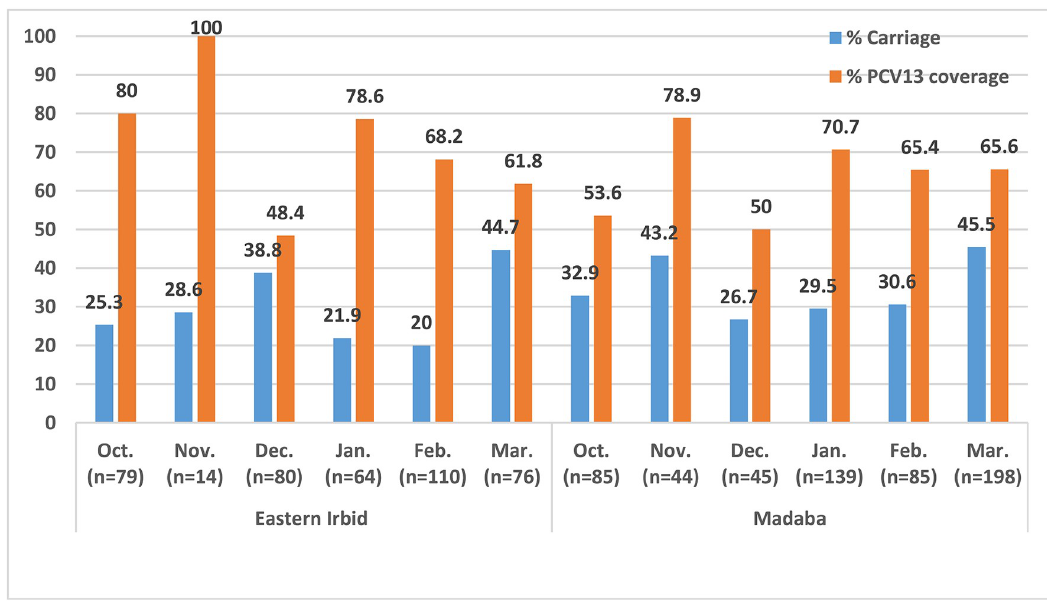
Fig 1. Distribution of carriage and PCV13 coverage rates according to the month of isolation from Irbid and Madaba in both winter seasons.